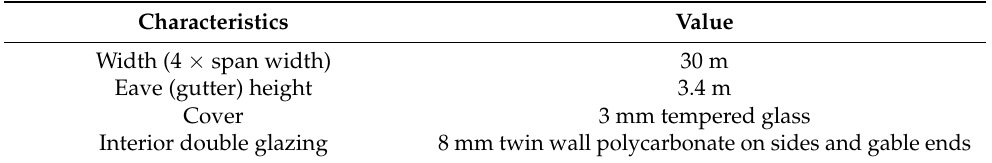
Table 1. The constructive properties of the greenhouse [48]. Characteristics